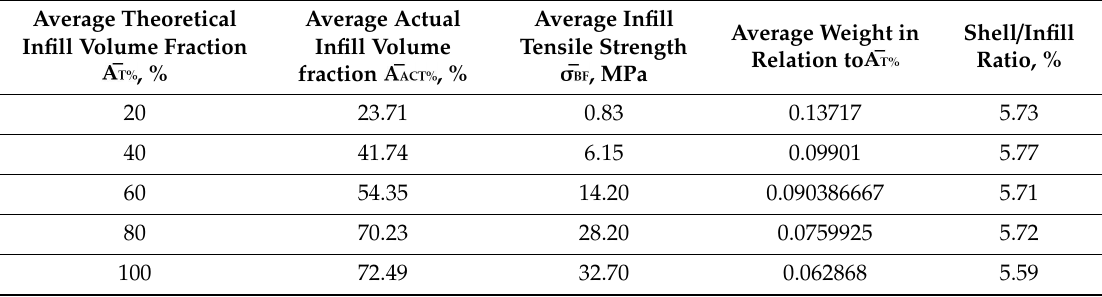
Table 3. Average arithmetic values of the volume fraction and the tensile strength of the infill structure. Average Theoretical Infill Volume